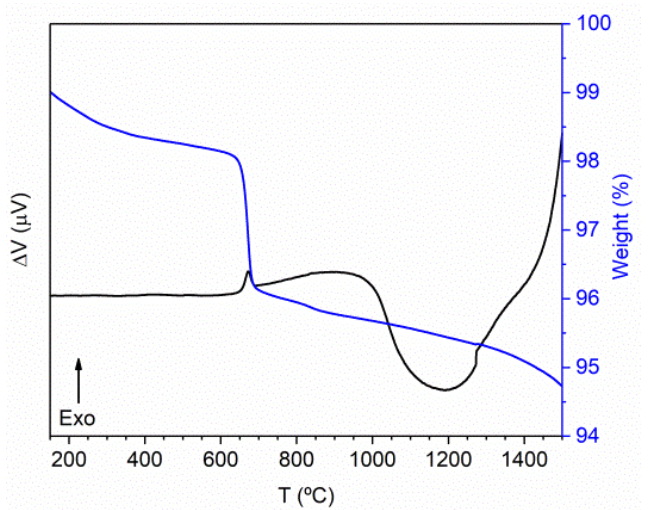
Figure 1. DTA/TGA thermograms of the Er-Nb obtained